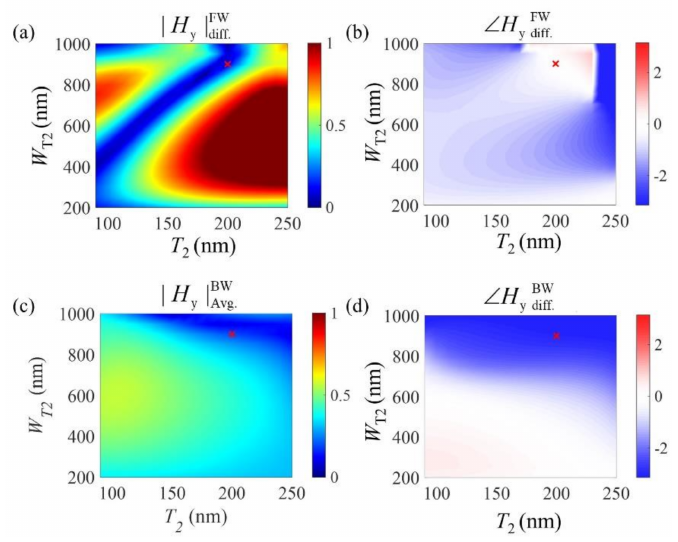
(cid:12) ) and ( b ) phase differences (cid:12) H y | FW diff. (cid:12) (cid:12) | BW ) and ( d ) phase difference between the two slits (cid:12) H y Avg.